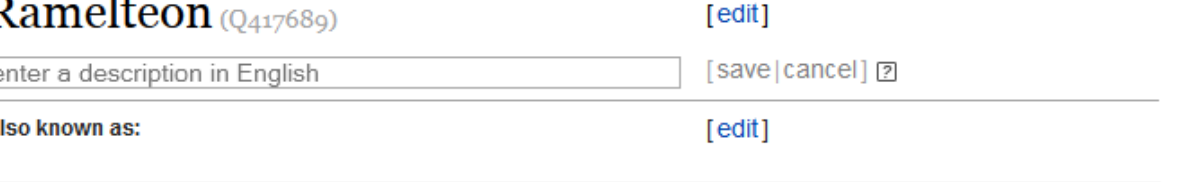
Figure 2. Screenshot of drug interaction data for the pharmaceutical ramelteon in the Wikidata system. A large number of other properties not pertaining to drug-drug interaction data have been removed from the